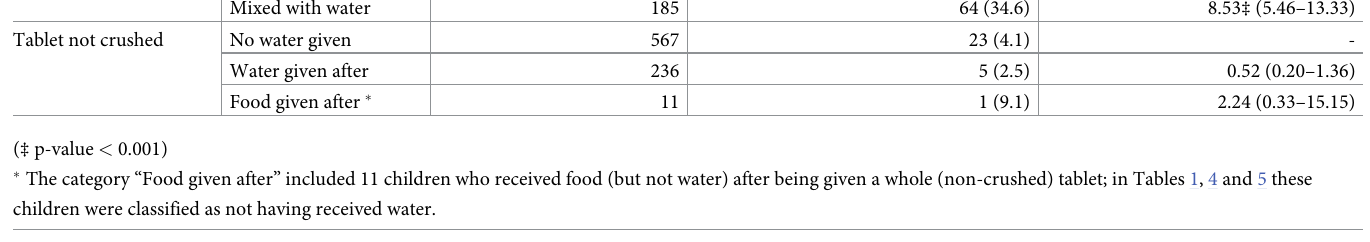
Table 3. Risk of adverse swallowing events, by tablet form and whether and how water was given. Administration Method